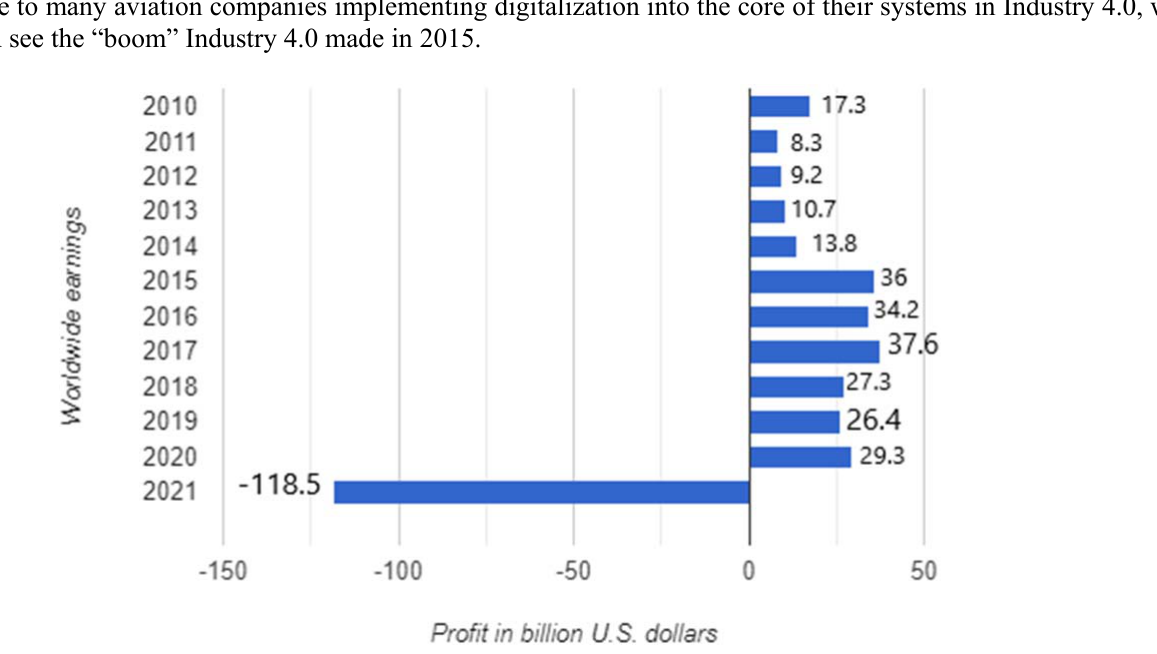
Figure 12. Profit due to digitalization in the aviation industry in period 2010 -